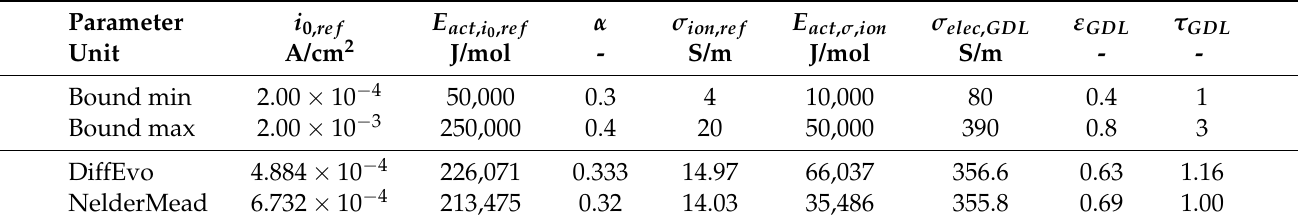
Table 5. Bounds of the design variables for global optimization and results from the numerical optimization process. DiffEvo represents the values obtained from the differential-evolution algorithm. These parameters are used as starting vector for the Nelder–Mead Simplex Algorithm to find the local minimum more accurately. The final set of parameters is shown in row